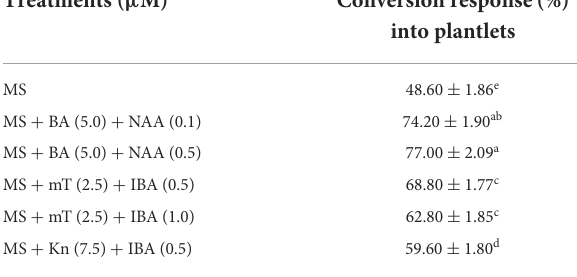
TABLE 6 Conversion response (means ± SE) of encapsulated NS on different treatments (8 weeks after culture). Treatments ( µ M)